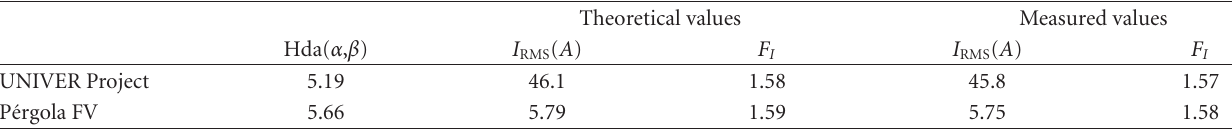
Table 5: Theoretical and measured values of irradiation, RMS current and current factor for “P´ergola Fotovoltaica” and UNIVER Project System